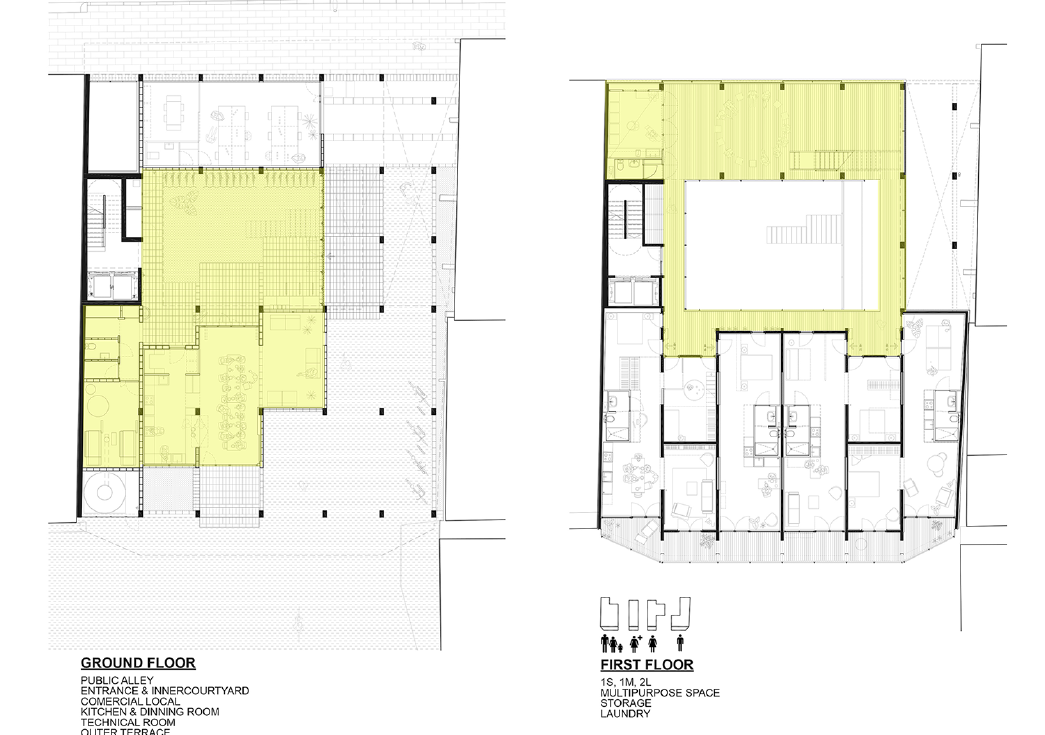
Figure 12. La Borda (Ground- and first floor), Barcelona, 2018, by LaCol Architectura Cooperativa. Image courtesy of LaCol Architectura Cooperativa. Note: the highlighted areas correspond to the common spaces.